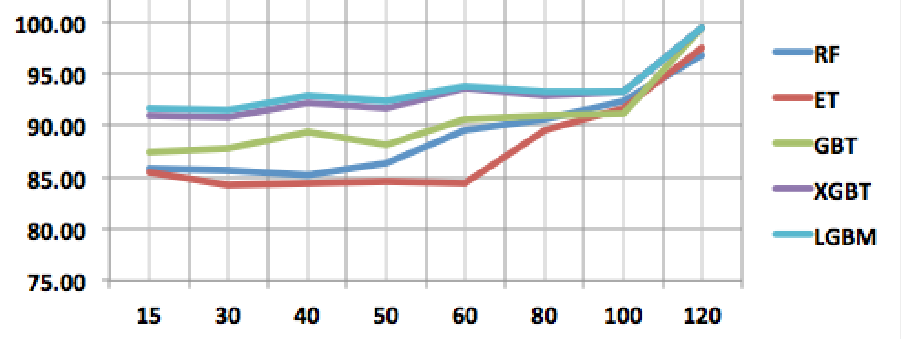
Appl. Sci. 2023 , 13 , x FOR PEER REVIEW Figure 6. Performance sensitivity analysis of all models in holdout strategy. Figure 6. Performance sensitivity analysis of all models in holdout strategy.